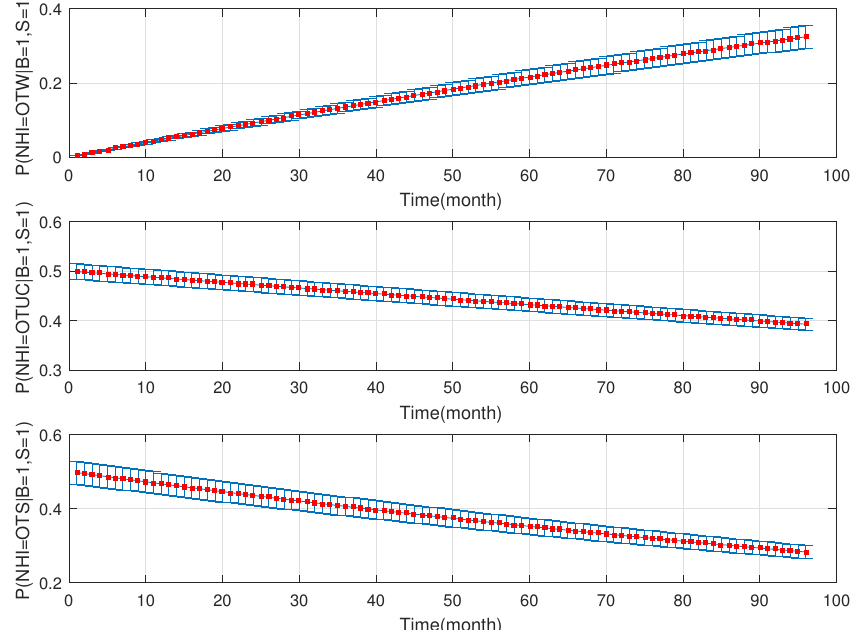
Figure 11. The probability of new herd incident (NHI) (officially TB free status withdrawn (OTW), officially TB free status unclassified (OTUC), officially TB free status suspended (OTS)) in high-risk areas of England where B: badgers density is ( > 3 setts/ha); and S: silage